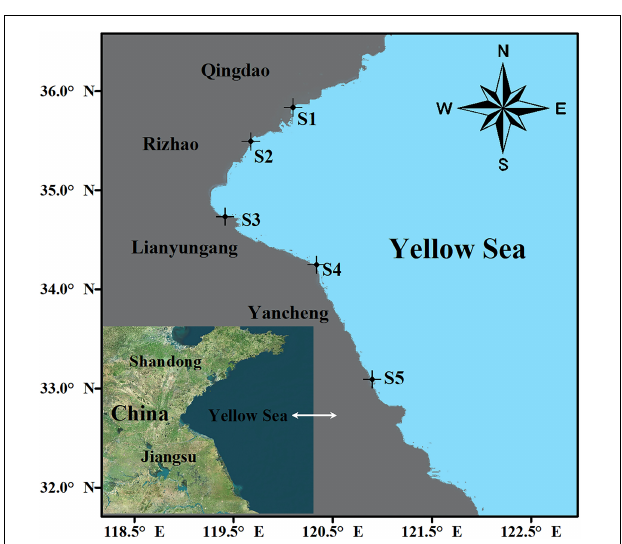
FIGURE 1 | Geographic position of five sampling sites along with coastal areas in the Yellow